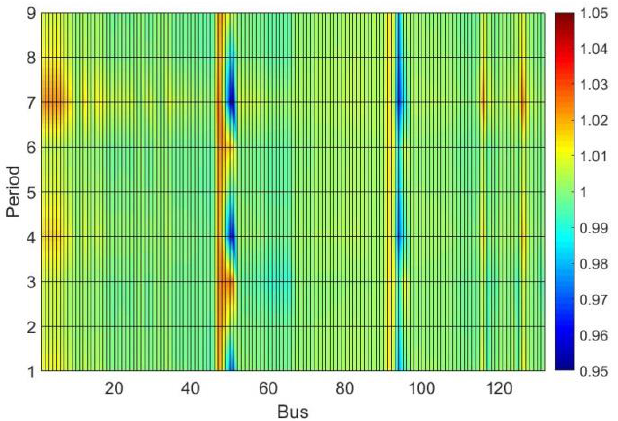
Figure 12. Continuous and discrete adjustment of taps, 70% PV.